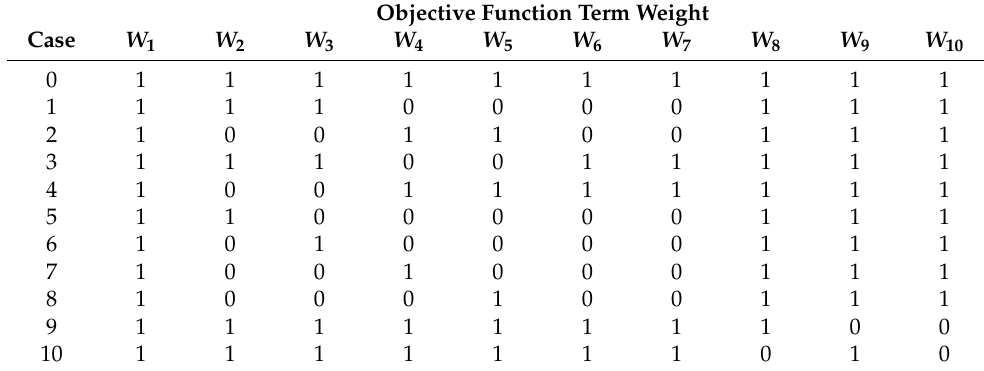
Table 11. Values of the weights of the objective function terms in Problem-4 in eleven different cases.